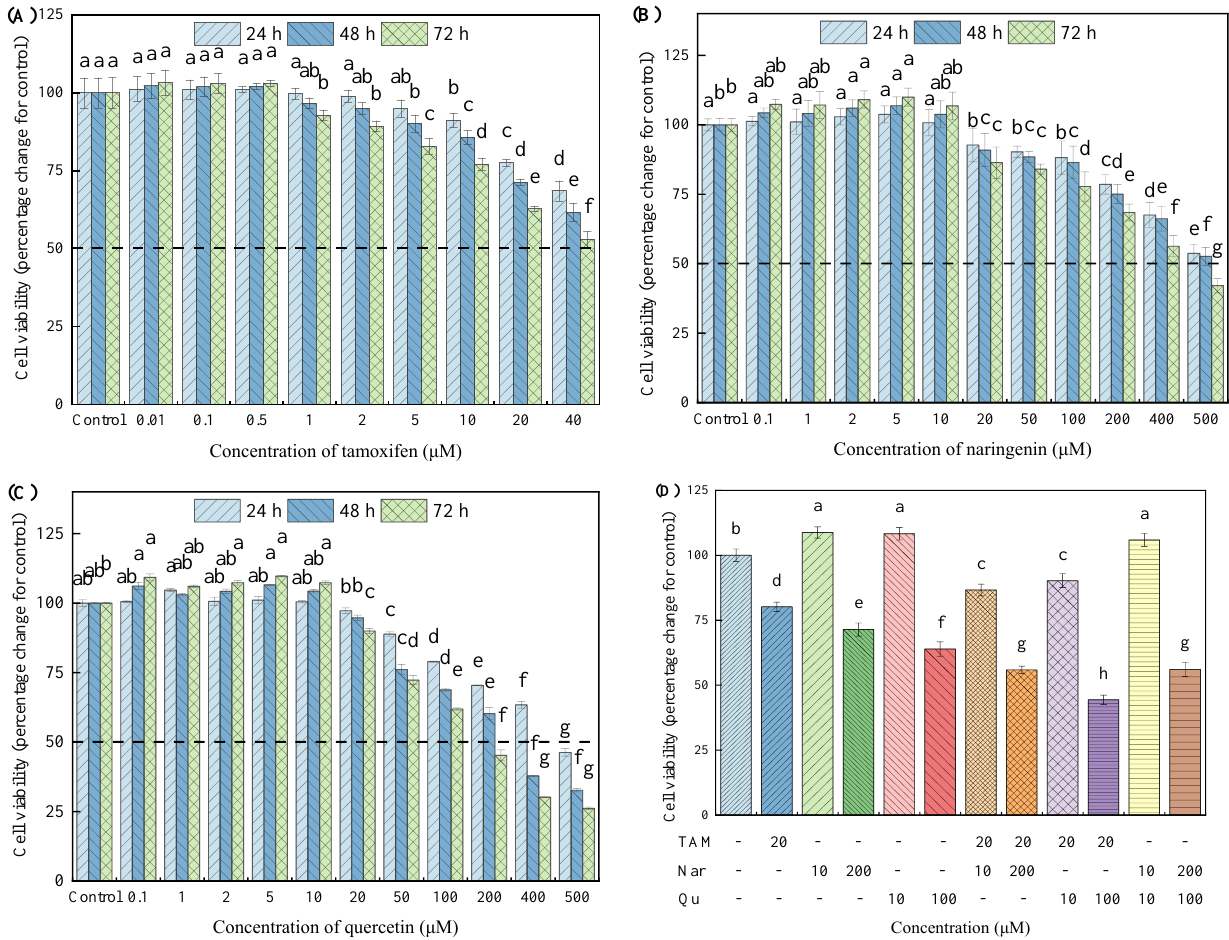
Figure 1. Effects of increasing concentrations of tamoxifen, naringenin and quercetin or their com- bined treatment on cell proliferation and cytotoxicity using CCK-8 assay in HepG2 cells. Cells were exposed to tamoxifen ( A ), naringenin ( B ) and quercetin ( C ) either alone or in combination ( D ) for 24, 48 and 72 h, respectively, and then the cell viability was measured using a CCK-8 assay ac- cording to the manufacturer instructions. Results are expressed as mean ± SD of three independent experiments ( n = 6). a,b,c,d,e,f,g,h : Different letters indicate significant differences ( p < 0.05) in cell via- bility after cells were treated with tamoxifen, naringenin and quercetin alone or in combination. The hyphen (-) symbolizes HepG2 cells were not treated with tamoxifen, naringenin or quercetin. TAM means tamoxifen, Nar means naringenin, and Qu means quercetin, all of the abbreviations in this article are represented in this way.